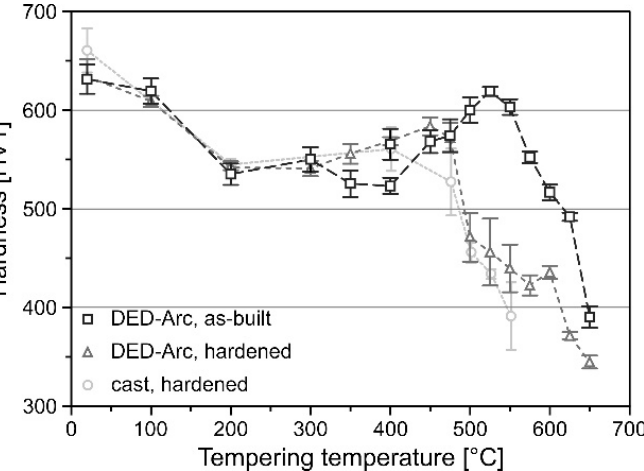
Figure 11. Influence of tempering on the hardness of tool steel X36 processed by DED-Arc and casting according to Großwendt et al. [40].